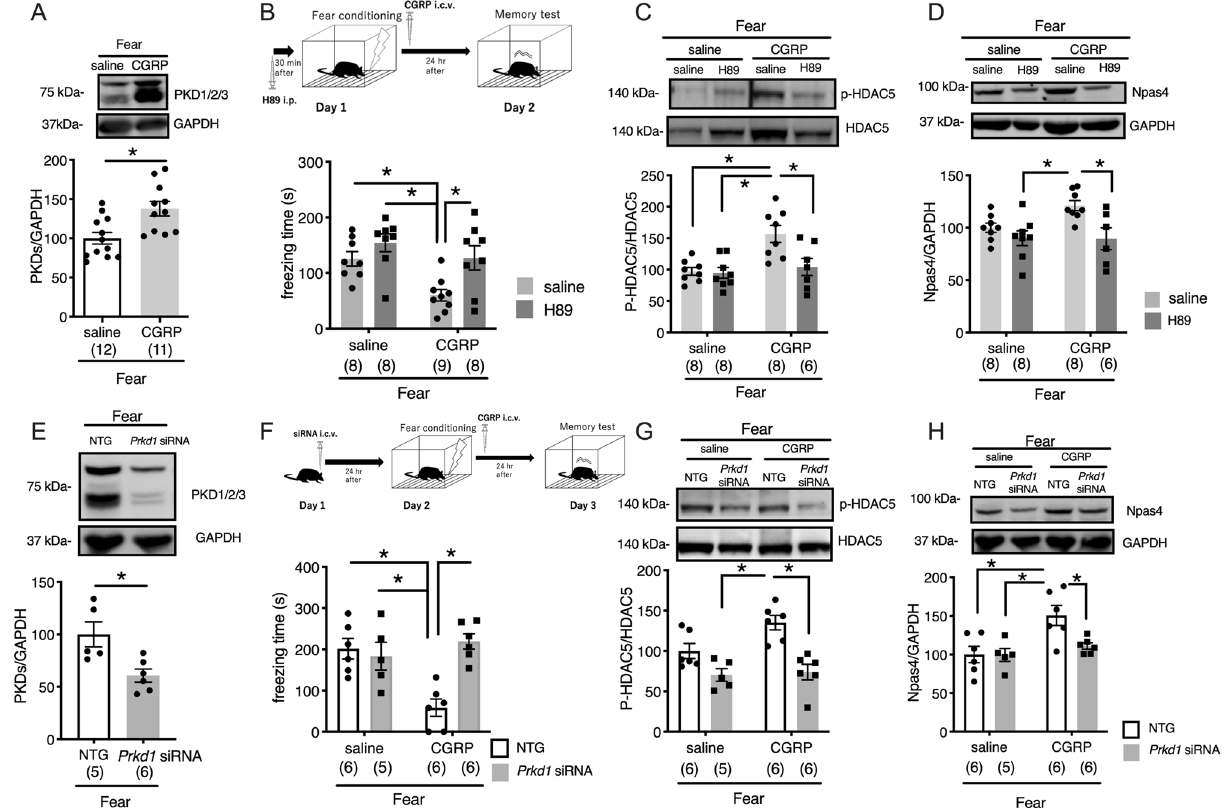
Figure 4. The CGRP-PKD pathway is required for the impairment of fear memory retention, via phosphorylated HDAC5 and Npas4 ( A ) PKD family member expression after fear conditioning (Welch’s t test, p = 0.0025). ( B ) Freezing time during the contextual fear learning test after treatment with H89 (Two-way ANOVA, interaction, F 1,29 = 1.515, p = 0.2283; CGRP, F 1,29 = 8.817, p = 0.0059; H89, F 1,29 = 9.474, p = 0.0045, One-way ANOVA, F 3,28 = 6.926, with Tukey’s test). ( C ) Phosphorylated HDAC5 expression (Two-way ANOVA, interaction,